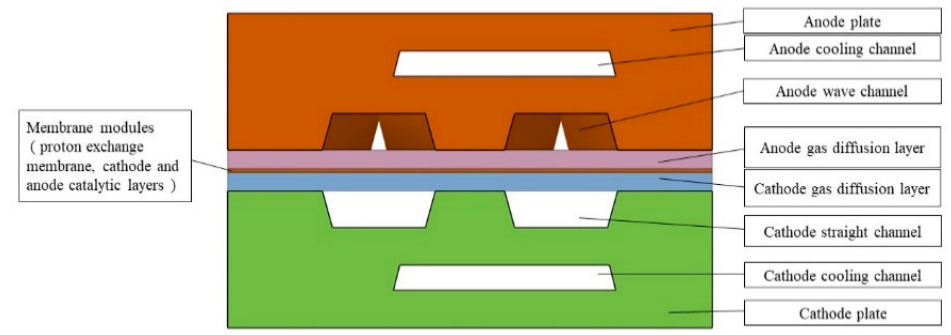
Figure 1. Three-dimensional geometric model of PEMFC. Table 1. Geometric model parameters of fuel cell. Geometric Parameter